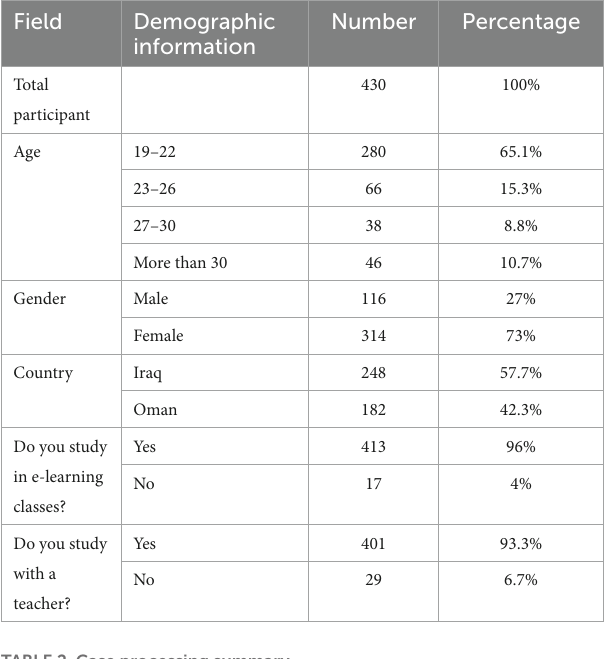
TABLE 1 Demographic information of participants.